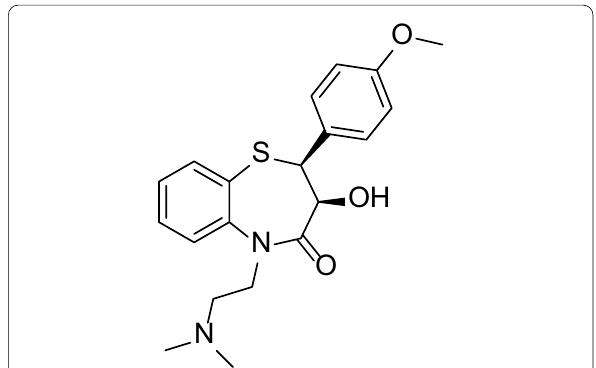
Fig. 6 Chemical structure of diltiazem EP impurity-F